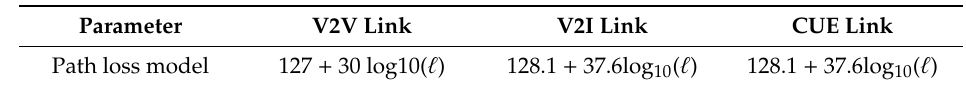
Table 3. Channel